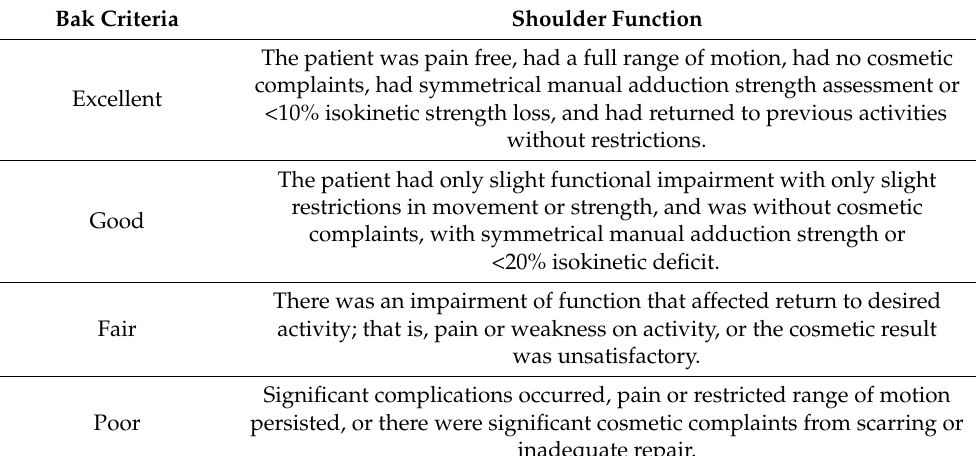
Table 2. Bak criteria